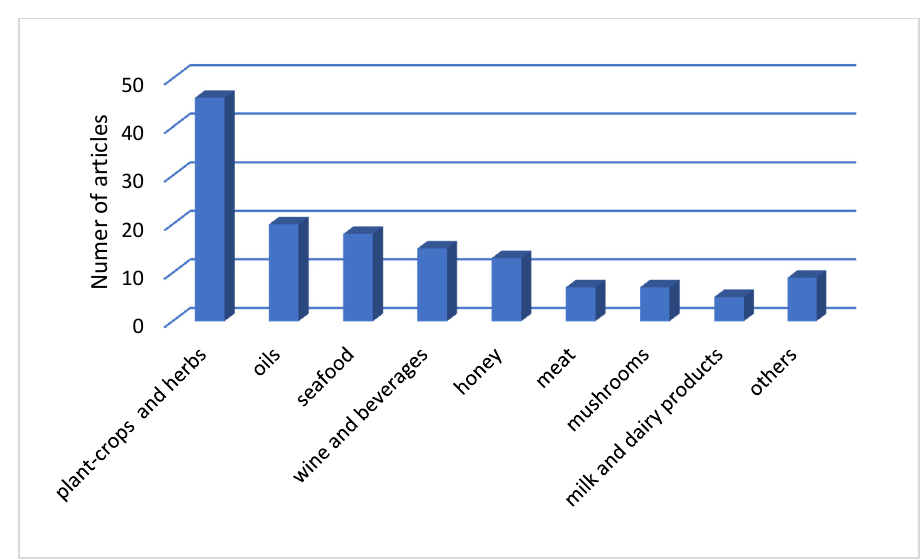
Figure 3. Number of articles according to the type of product.